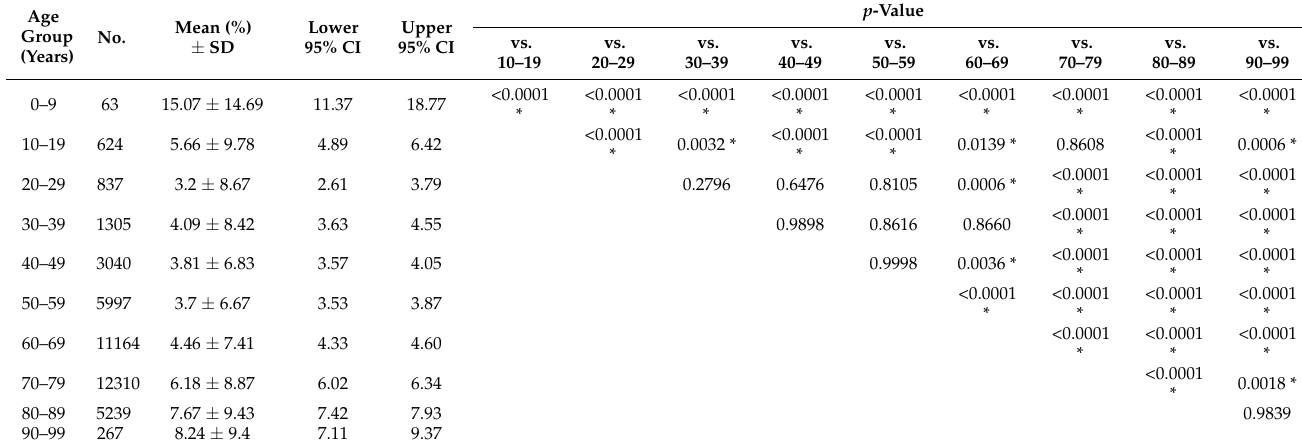
Table 4. Comparison of FNs among age-stratified groups.